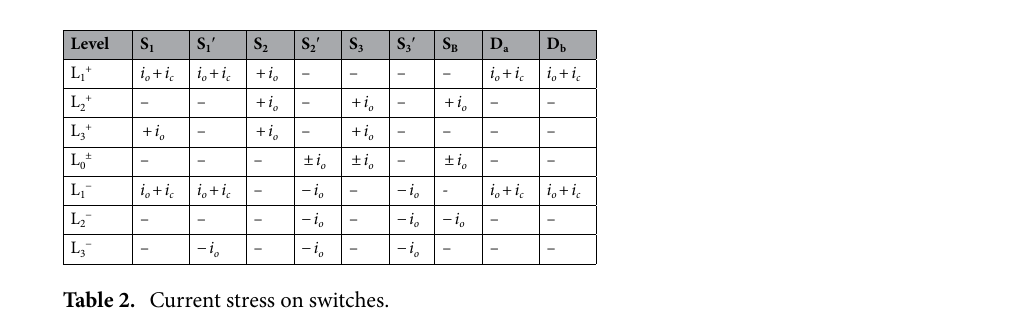
Table 2. Current stress on switches.